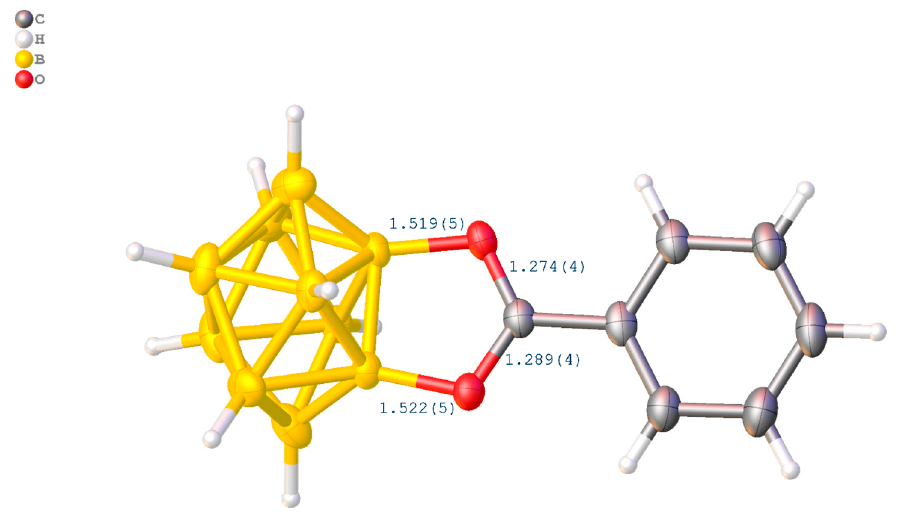
− anion. Length units—Å. Figure 1. X-ray Structure of [B 10 H 8 O 2 CC 6 H 5 ]